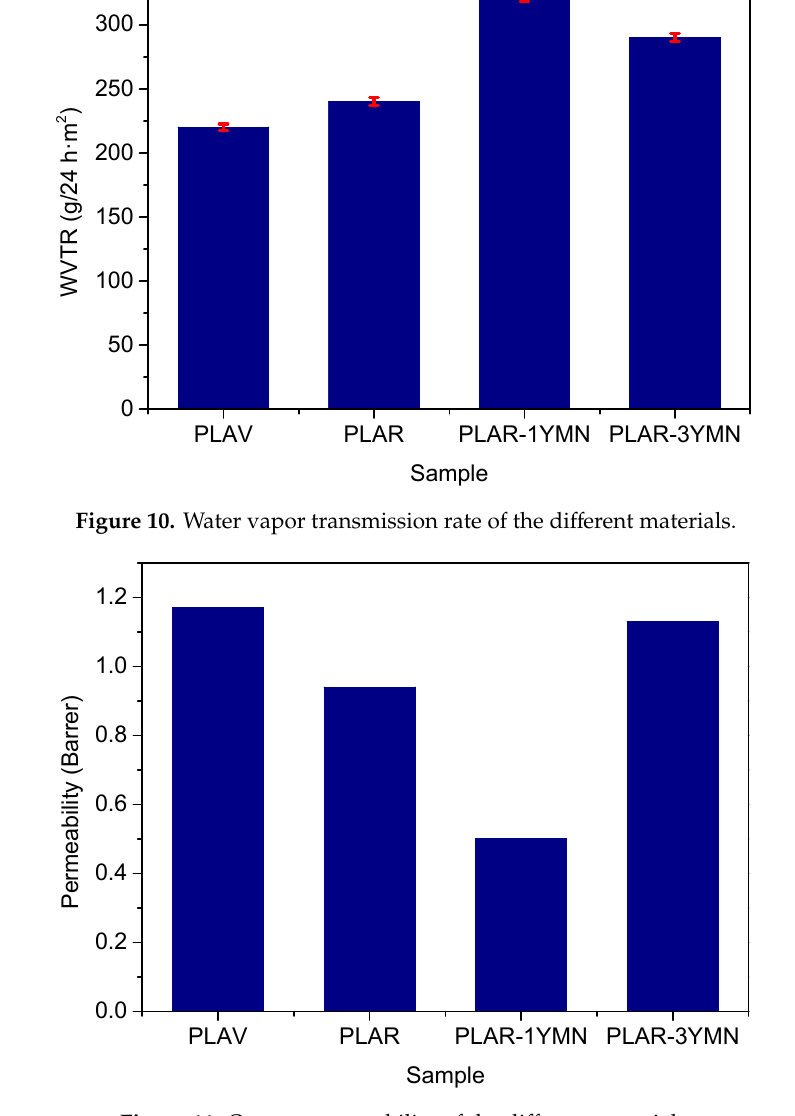
Figure 11. Oxygen permeability of the different materials.